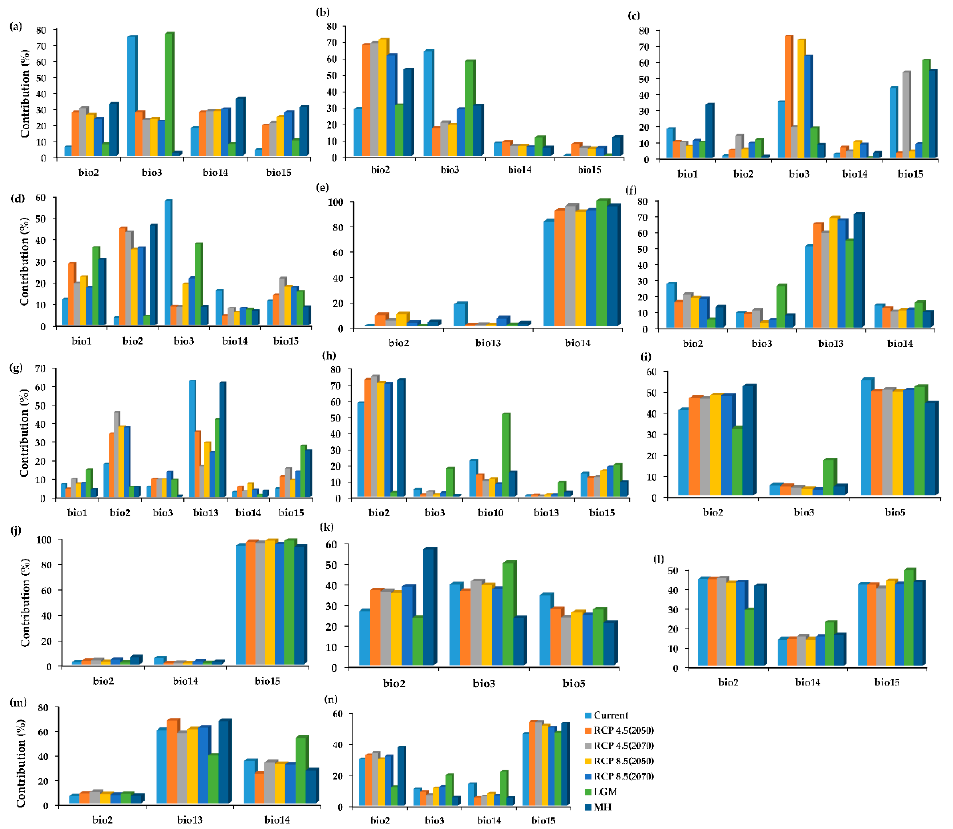
Figure 1. Estimates of the relative contributions of the environmental variables using MaxEnt models, fitted to the current, past, and future projections for Nymphaea species in Australia. ( a ) N. atrans , ( b ) N. elleniae , ( c ) N. georginae , ( d ) N. hastifolia , ( e ) N. jacobsii , ( f ) N. pubescens , ( g ) N. ondinea , ( h ) N. alba , ( i ) N. nouchali , ( j ) N. carpentariae , ( k ) N. gigantea , ( l ) N. immutabilis , ( m ) N. macrosperma , and ( n ) N. violancea .